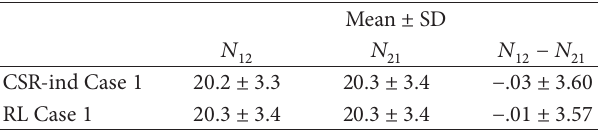
Table 7: The means ( ± SD) of the off-diagonal entries, 𝑁 12 , 𝑁 21 , and their difference 𝑁 12 − 𝑁 21 under CSR independence Case 1 and RL Case 1 with 𝑛 1 = 𝑛 2 = 40 at 𝛼 = .05